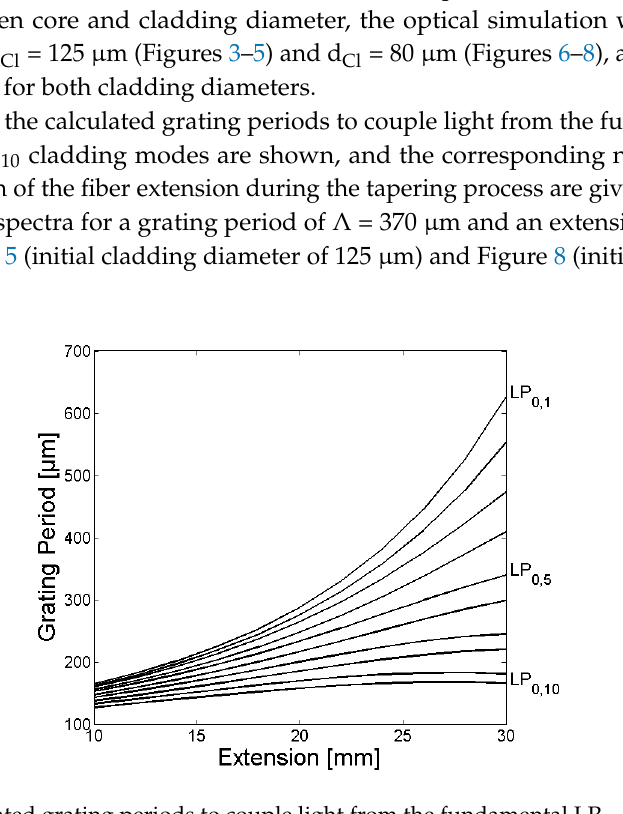
Figure 3. The calculated grating periods to couple light from the fundamental LP 0,1 core mode to the LP 0,1 –LP 0,10 cladding modes for the SM1500 fiber with a starting cladding diameter of 125 μ m are shown as a function of the fiber extension l, whereby the grating periods for coupling decrease steadily with increasing mode numbers.